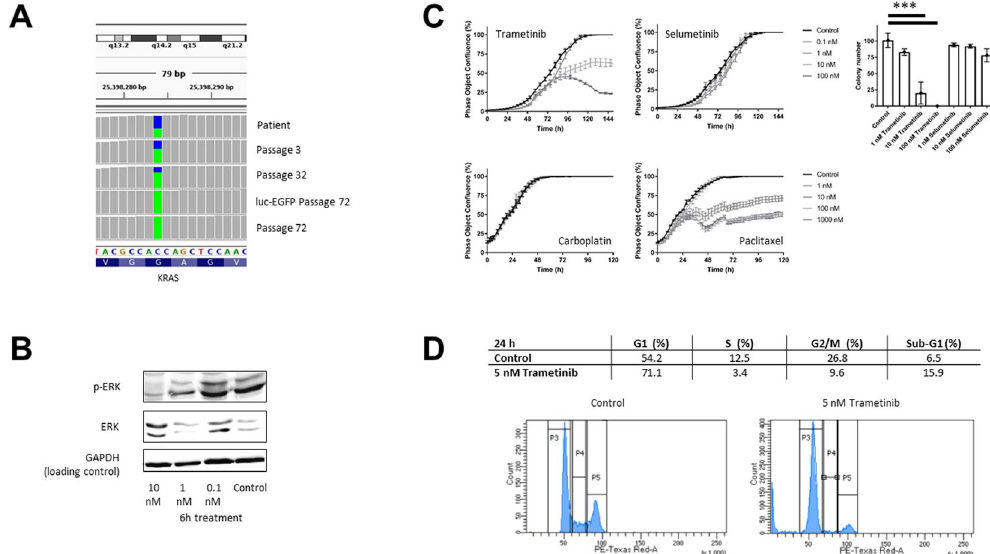
Figure 3. In vitro effect of trametinib on KRAS mutated PM-PDX-derived cells. ( A ) KRAS c.35 G > T (p.(Gly12Val)) mutation analysis at patient material, different in vitro passages of the PM-LGSOC-01 cell line (3, 32 and 72) and for the luc-EGFP positive PM-LGSOC-01 cells. The colors blue and green indicate the fraction wildtype versus mutant, respectively. This image was created by third author J. Van der Meulen using the visualization tool Integrative Genomics Viewer (IGV, https://software.broadinstitute.org/software/ igv/) 37 . The complete figure is illustrated in Supplementary Figure S4. ( B ) Immunoblotting results for p-ERK and ERK of the PM-LGSOC-01 cell line treated with 0.1% DMSO (control) and trametinib at a concentration of 0.1, 1 and 10 nM for 6 hours. GAPDH was used as the loading control (Supplementary Figure S3). ( C ) On the left, real-time analysis of PM-PDX-derived cell confluency using IncuCyte technology. PM-LGSOC-01 cells were treated with 0.1% DMSO (control), trametinib, selumetinib, carboplatin and paclitaxel at concentrations of 0.1, 1, 10, 100 and 1000 nM. Mean ± SEM of at least four technical replicates is shown. On the right, results on the clonogenicity assay. PM-LGSOC-01 cells were treated for 1 week with trametinib or selumetinib at a concentration of 1, 10 and 100 nM. Mean ± SEM of three technical replicates is shown. Statistical analysis was performed using one-way ANOVA at the α = 0.05 significance level. ( D ) Results of the cell cycle distribution analysis by flow cytometry. Quantitation of the sub-population fractions of the histograms. PM-LGSOC-01 cells were treated for 24 hours with 0.1% DMSO (control) or 5 nM trametinib. Many cells were blocked in the G0/G1 phase and a reduction in the S and G2/M phase was observed with increasing concentration of